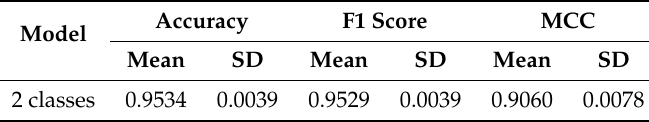
Table 5. Performance measures with selected variables.